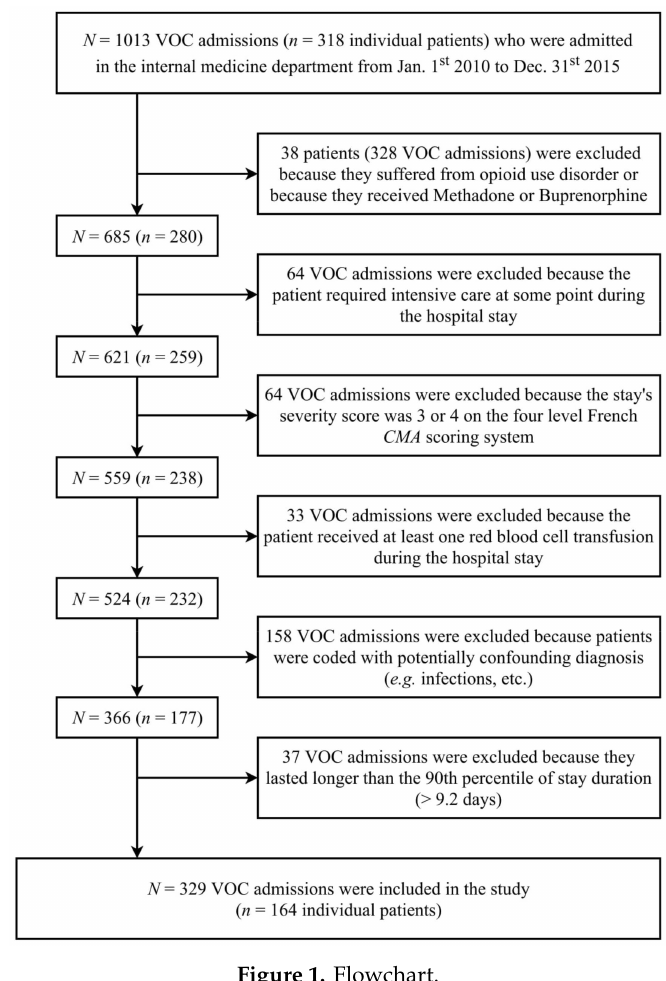
Figure 1. Flowchart. Table 1. Population description and comparison of patients’ characteristics between